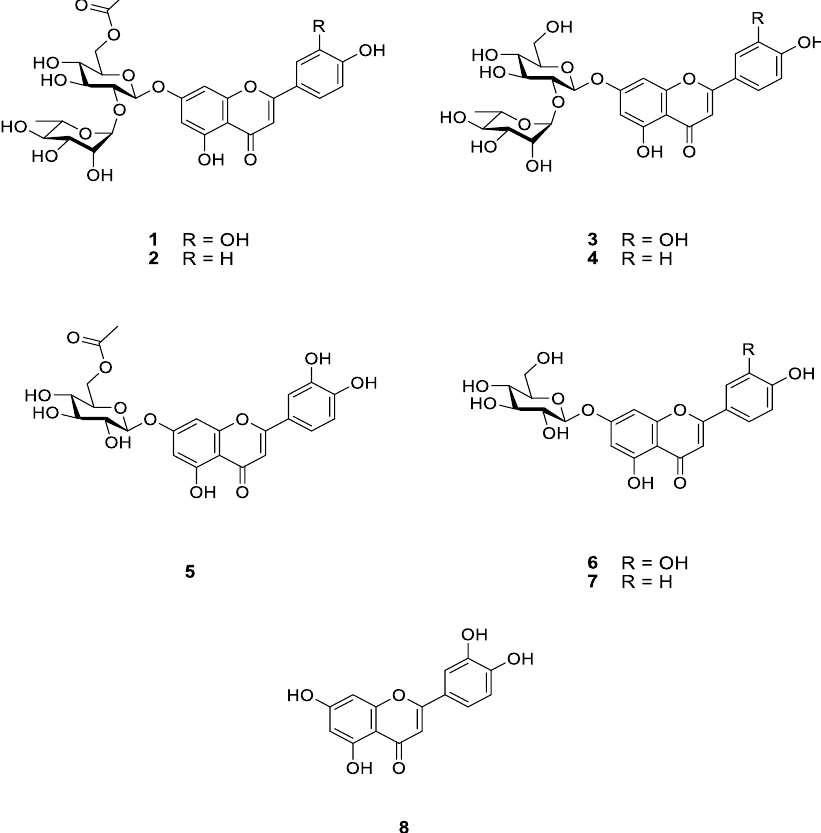
Figure 5. Structures of compounds 1 – 8 from the aerial part of P. grandiflorus . Dorajiside I ( 1 ): yellowish amorphous powder; mp 167–168 ◦ C; UV (MeOH) λ max (log ε ) 255 (4.33), 266sh (3.88), 350 (4.54); ESIMS (positive ion mode) m / z 637 [M + H] + ;